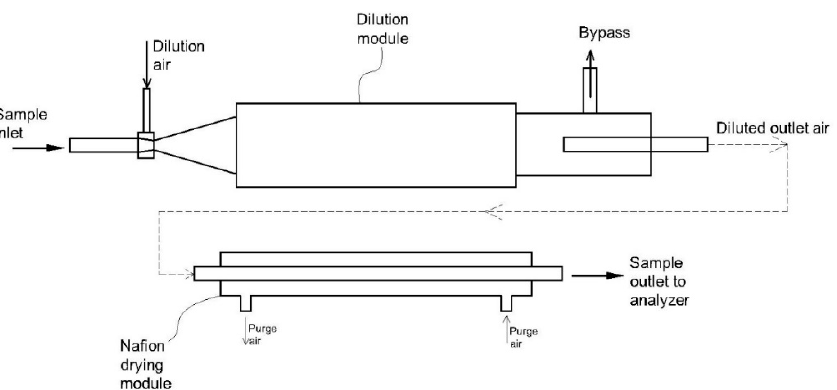
Figure 13. Schematic diagram of the hybrid dilution system for measuring low particulate matter emitted from a power plant [116].